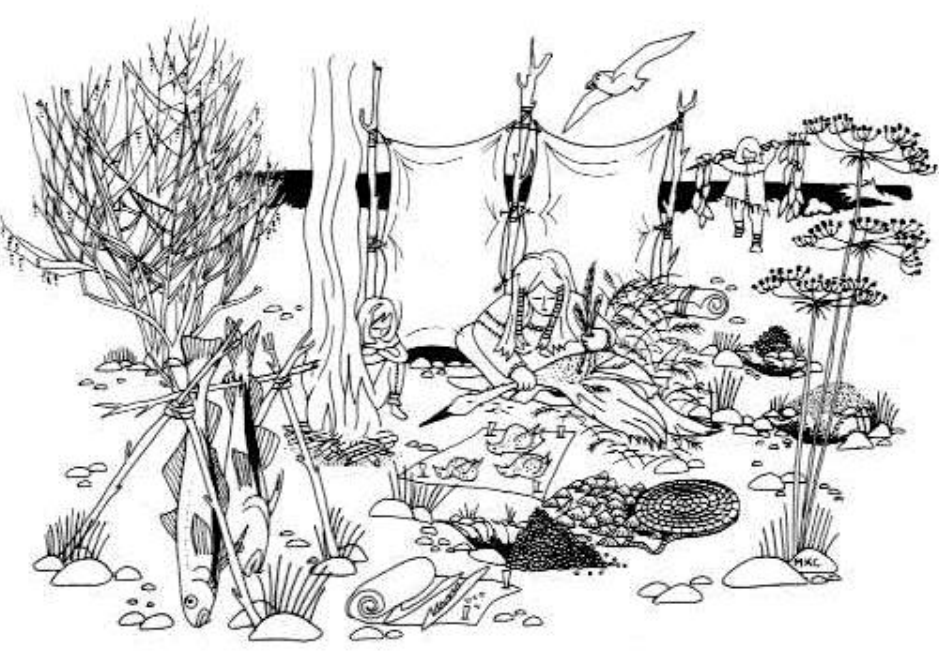
Figure 11 : Reconstruction by Mary Kemp-Clarke - meat smoking in early